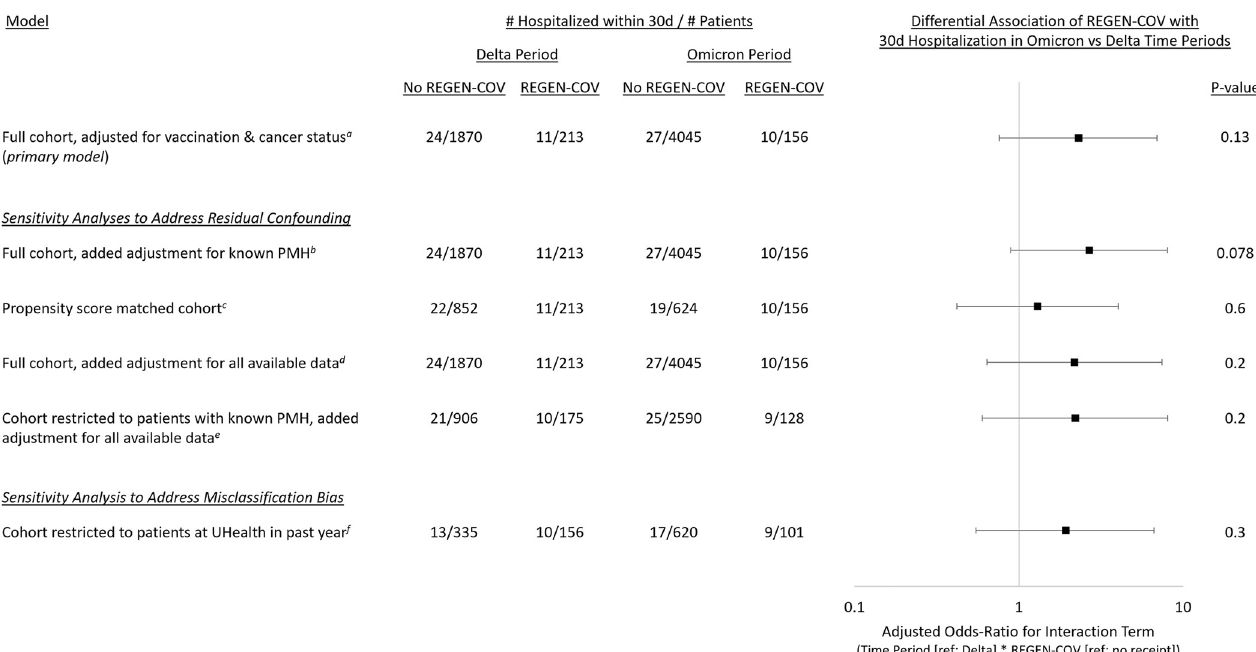
Fig 2. Differential association of REGEN-COV with hospitalization within 30 Days by time period. d: days; PMD: primary medical doctor; PMH: past medical history; ref: reference. a This is the primary model including adjustment for vaccination status (not, fully � 6 months prior, fully < 6 months prior), boosted, and cancer diagnosis. b This is model is the same as the primary model with the addition of a covariable for “known past medical history” which is determined by the presence of at least one ICD-10 code in the UHealth system. c The is the unadjusted model for the 1:4 (received REGEN-COV:not) propensity-matched cohort. The propensity score used for matching was created with the following covariables: vaccination status, boosted, age, gender, race/ ethnicity, payor, knowledge of past medical history, cancer diagnosis, and individual Elixhauser comorbidities. Patients were matched 1:4 without replacement using a caliper distance of 25% of the standard deviation of all propensity scores. The matched cohort is described in S1 Table. d This is the overfit model including the following covariables: vaccination status, boosted, age, gender, race/ethnicity, payor, knowledge of past medical history, and individual Elixhauser comorbidities. e This is the same overfit model as in (d) with the cohort restricted to include only patients with “known past medical history”. f This is the primary model, but restricted to patients who visited (hospital or emergency department) UHealth within the year prior to testing.